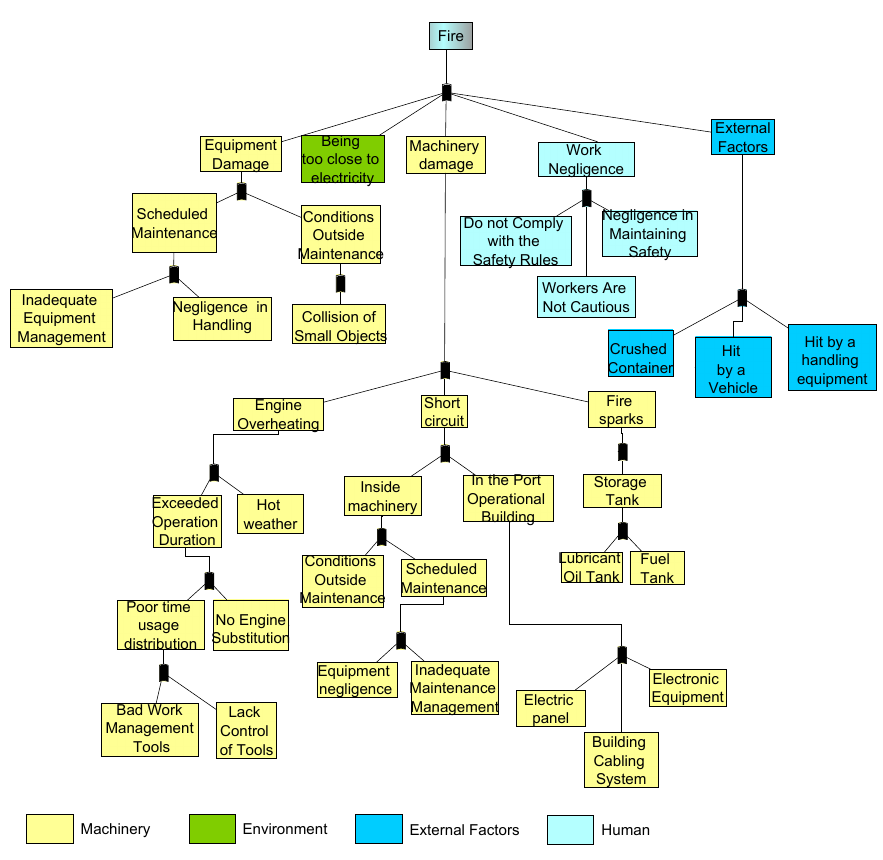
Figure 2. Fault Tree Analysis (FTA) of Fire.